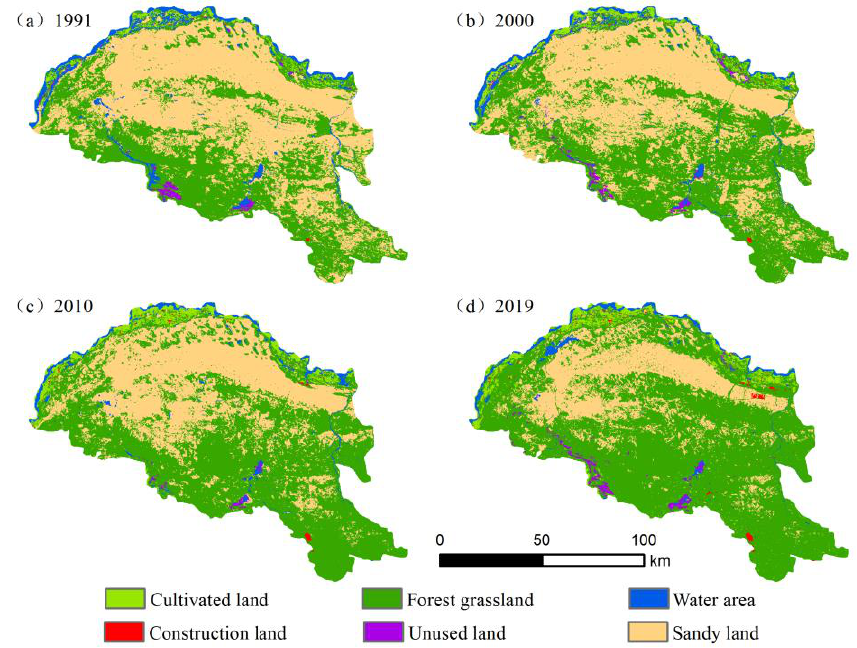
Figure 3. Spatial variation in land use in 1991, 2000, 2010, and 2019. Table 4. The area of land-use change in various periods along the Yellow River section of the Hobq Desert.